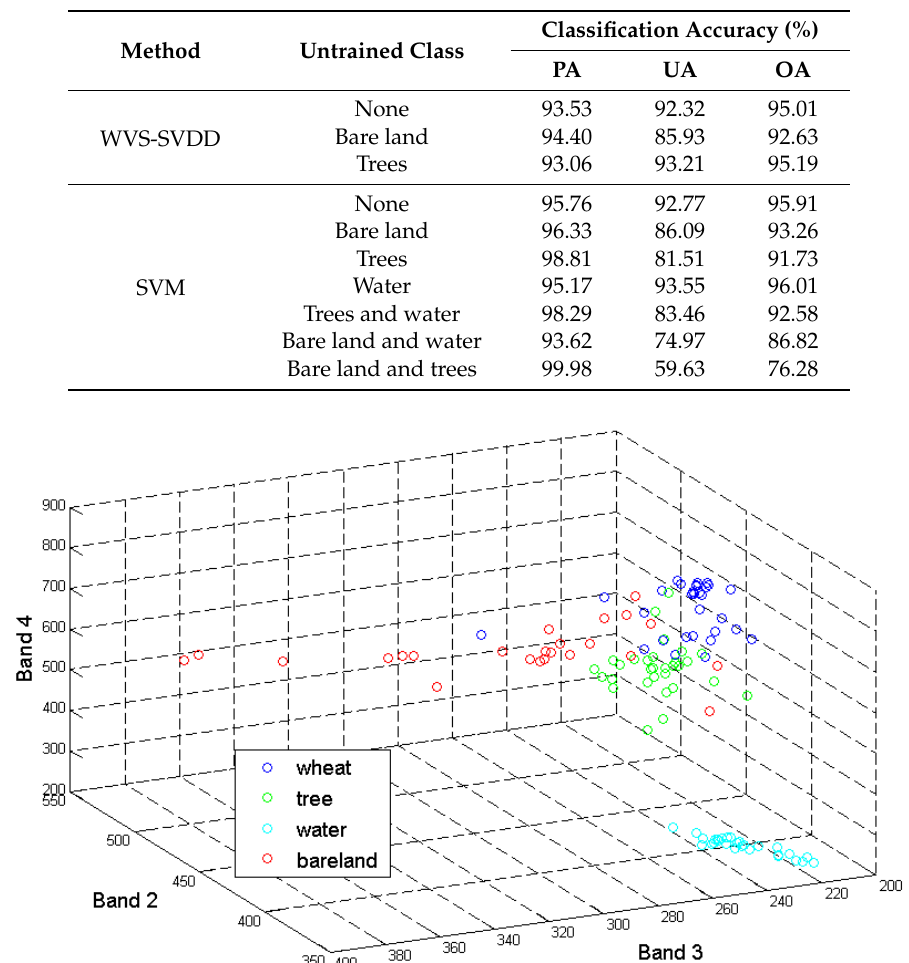
Table 4. Classification accuracy for SVDD and SVM classifications using an exhaustive and non-exhaustive training data set.